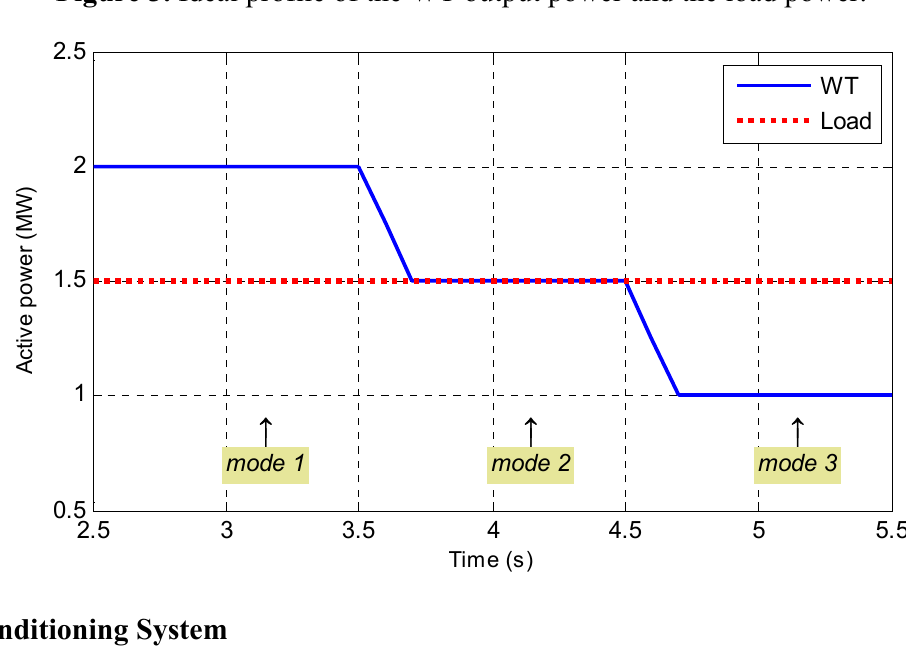
Figure 3. Ideal profile of the WT output power and the load